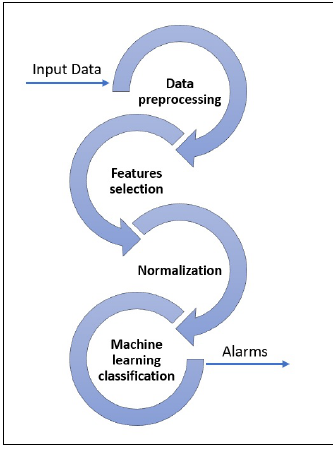
Figure 3. ML classification